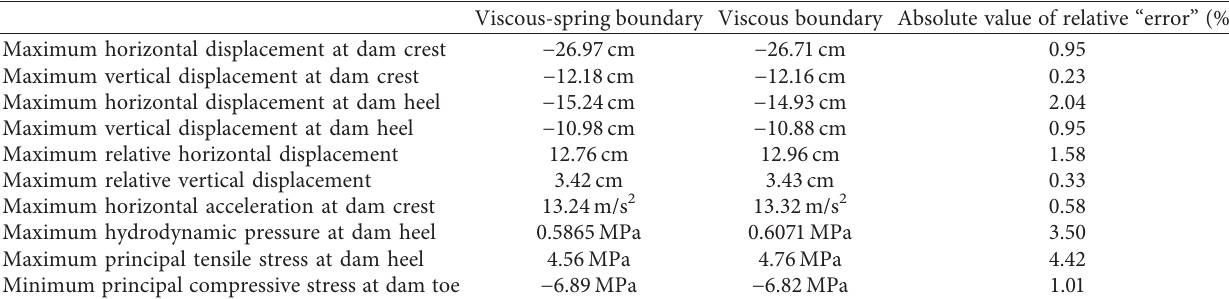
Figure 15: Time histories of input accelerations. (a) Horizontal component (b) Vertical component. Table 3: Result comparisons of the Jin’anqiao dam using different models.